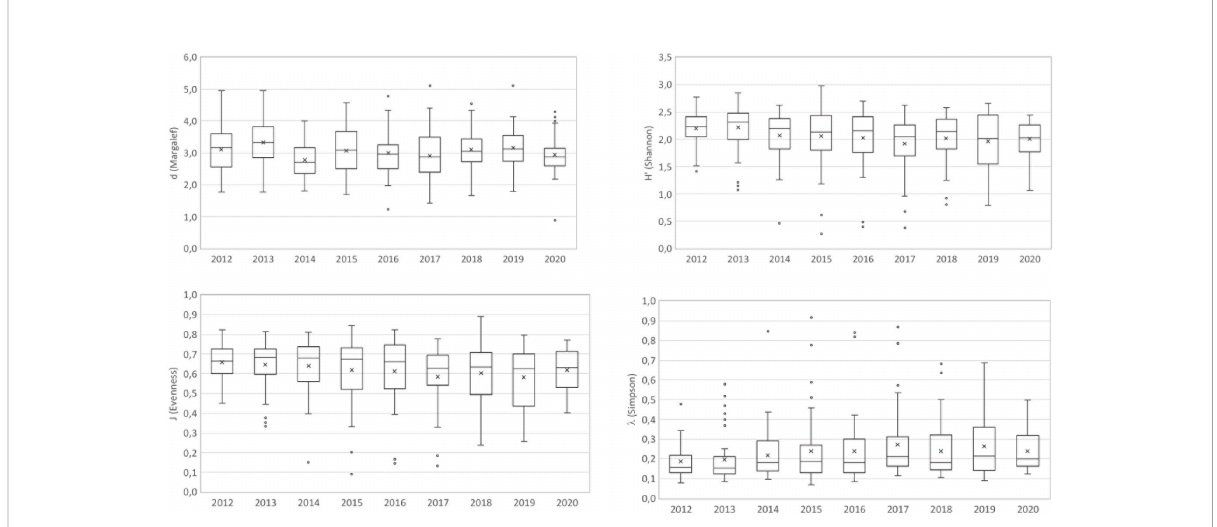
FIGURE 5 Boxplots of species richness (Margalef, d), diversity (Shannon-Wiener, H ’ ), evenness (Pielou, J) and dominance (Simpson, L ) computed by year for the deep-sea assemblages of the northwestern Ionian